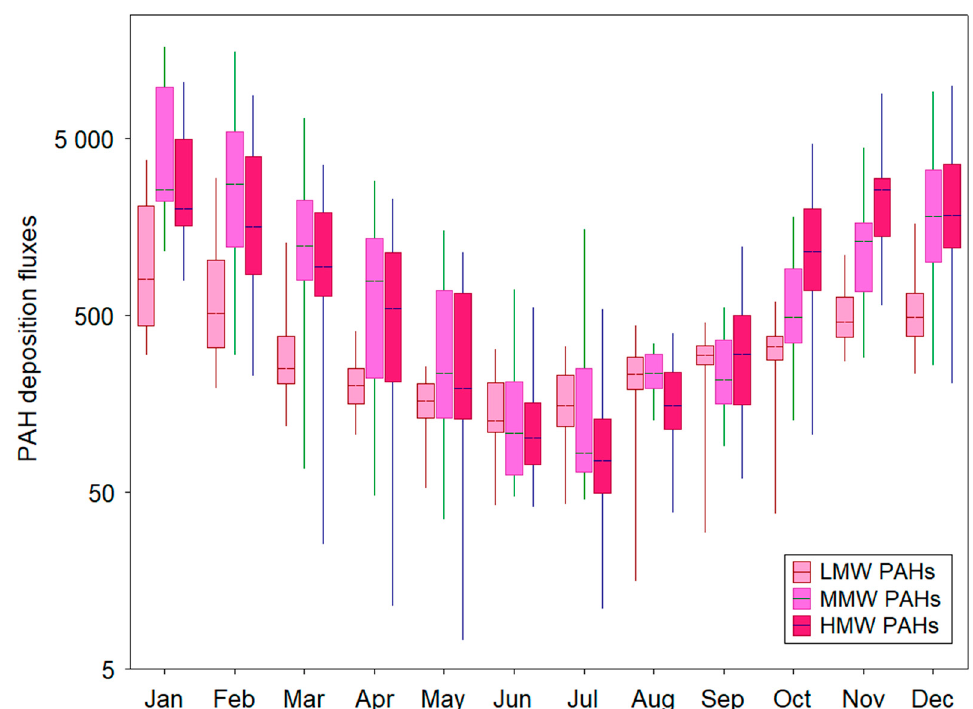
Figure 3. Monthly distribution of low-, medium- and high-molecular-weight PAH deposition fluxes in the coastal urban region of northern Poland. Box edges denote the 25th and 75th quartiles, the median value is indicated as a vertical line inside boxes, and whiskers stand for minimum and maximum.